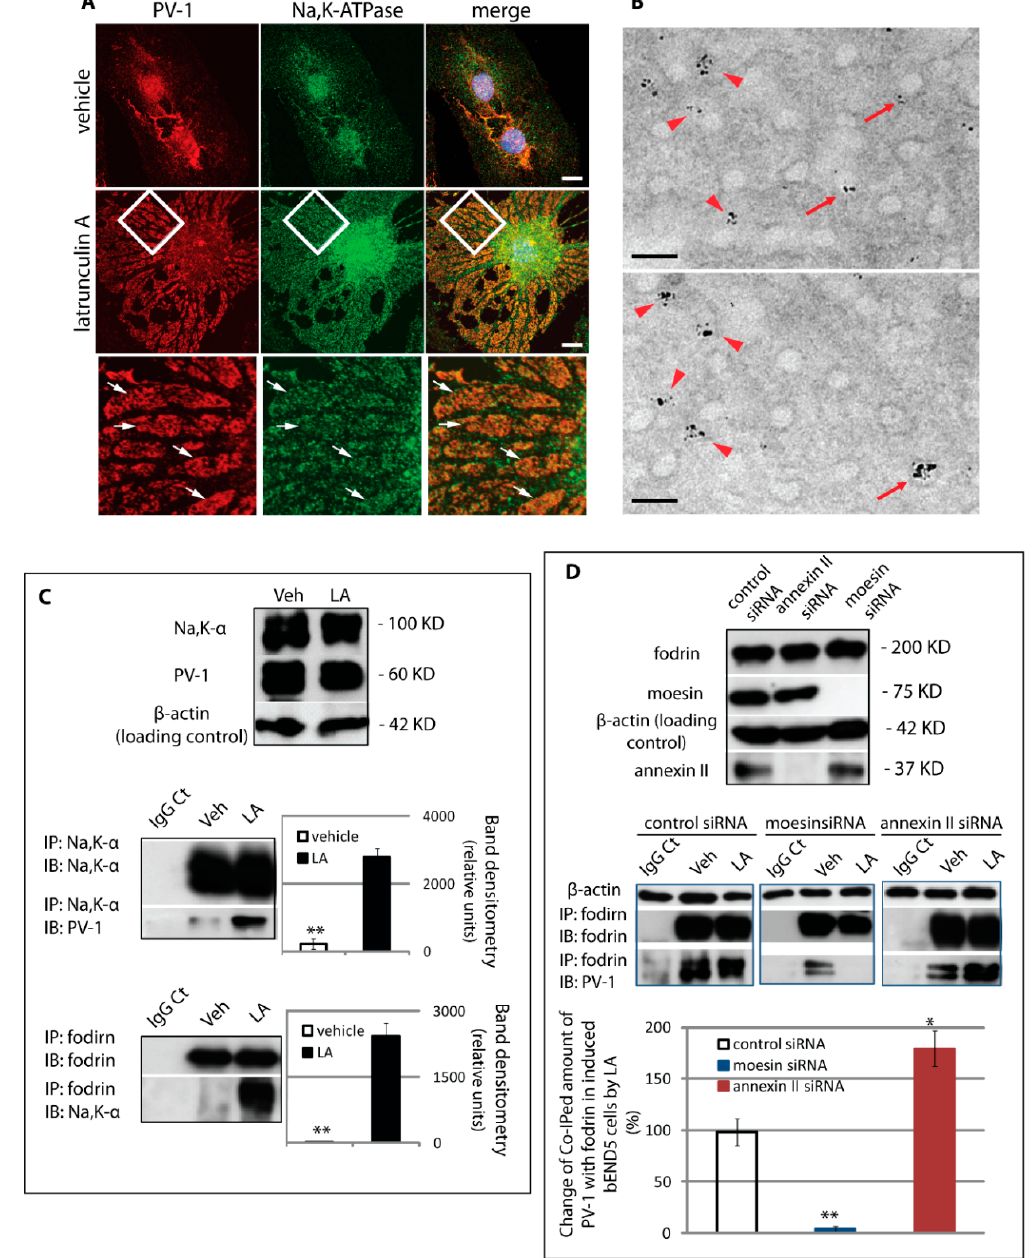
Figure 6. Na,K-ATPase is a transmembrane component of the fenestral sieve plates. ( A ) Following fenestra induction, Na,K-ATPase was enriched in the PV-1-positive sieve plates (arrows, fenestral sieve plates; scale bar, 10 µm). ( B ) Pre-embedding immunolabelling for Na,K- α subunit using a gold- conjugated Fab fragment and silver enhancement in thin sections cut along the plane of the cell monolayer revealed Na,K-ATPase labelling in the sieve plate area, localised either adjacent to the pore rim (arrowheads) or often on the rim of fenestral pores (arrows). Scale bar, 100 nm. ( C ) Immunoprecipitation revealed an increased association of Na,K- α and PV-1 proteins following induction of fenestra formation. The Na,K- α subunit also co-immunoprecipitated with fodrin in fenestrated cells. Mean and standard deviation of three experiments are shown. ** P < 0.0001. ( D ) The interaction between fodrin and PV-1 was regulated by moesin and annexin II. Expression of moesin or annexin II was successfully knocked down by siRNA. The bEND5 cells transfected with control siRNA, moesin siRNA, or annexin II siRNA were treated with vehicle or induced to form fenestrae. Immunoprecipitation with a fodrin antibody demonstrated that, in bEND5 cells that were fenestrated, the amount of co-immunoprecipitated (co-IPed) PV-1 with fodrin diminished upon moesin depletion